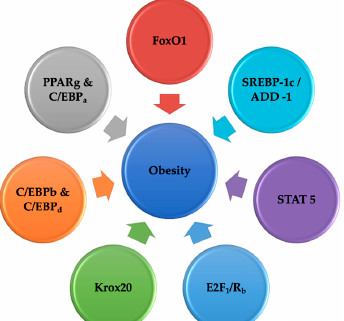
Figure 2. Transcription factors and transporters regulating obesity. Legend: PPARg—Peroxisome Proliferator Activated Receptor Gamma; C/EBP—gene; SREBP1—sterol regulatory element-binding protein 1; Krox20—member of early growth response (EGR) genes; E2F—retinoblastoma binding to E2 transcription factor; STAT 5—Signal transducer and activator of transcription 5; FoxO1-forkhead box protein O1; C/EBPb—enhancer-binding protein beta; C/EBPd—enhancer-binding protein delta; C/EBPa–CCAAT enhancer-binding protein alpha.